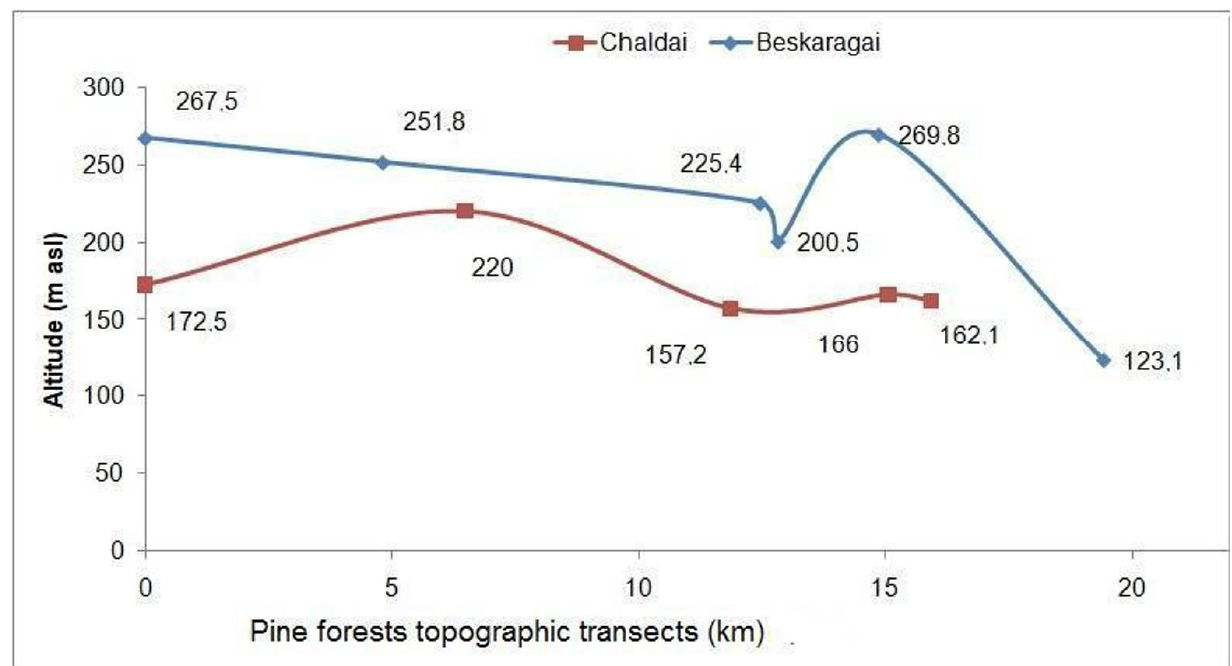
Figure 3. The geomorphic profiles of the investigated areas: the Beskaragai and Chaldai NR .